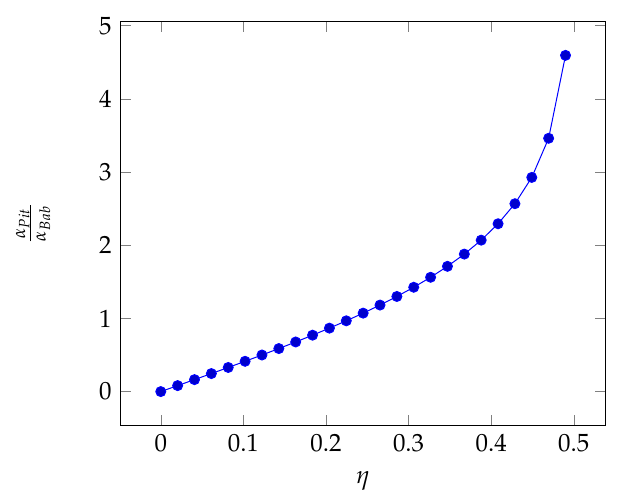
Figure 1. Ratio of the Pitacco and Babcock risk-aversion